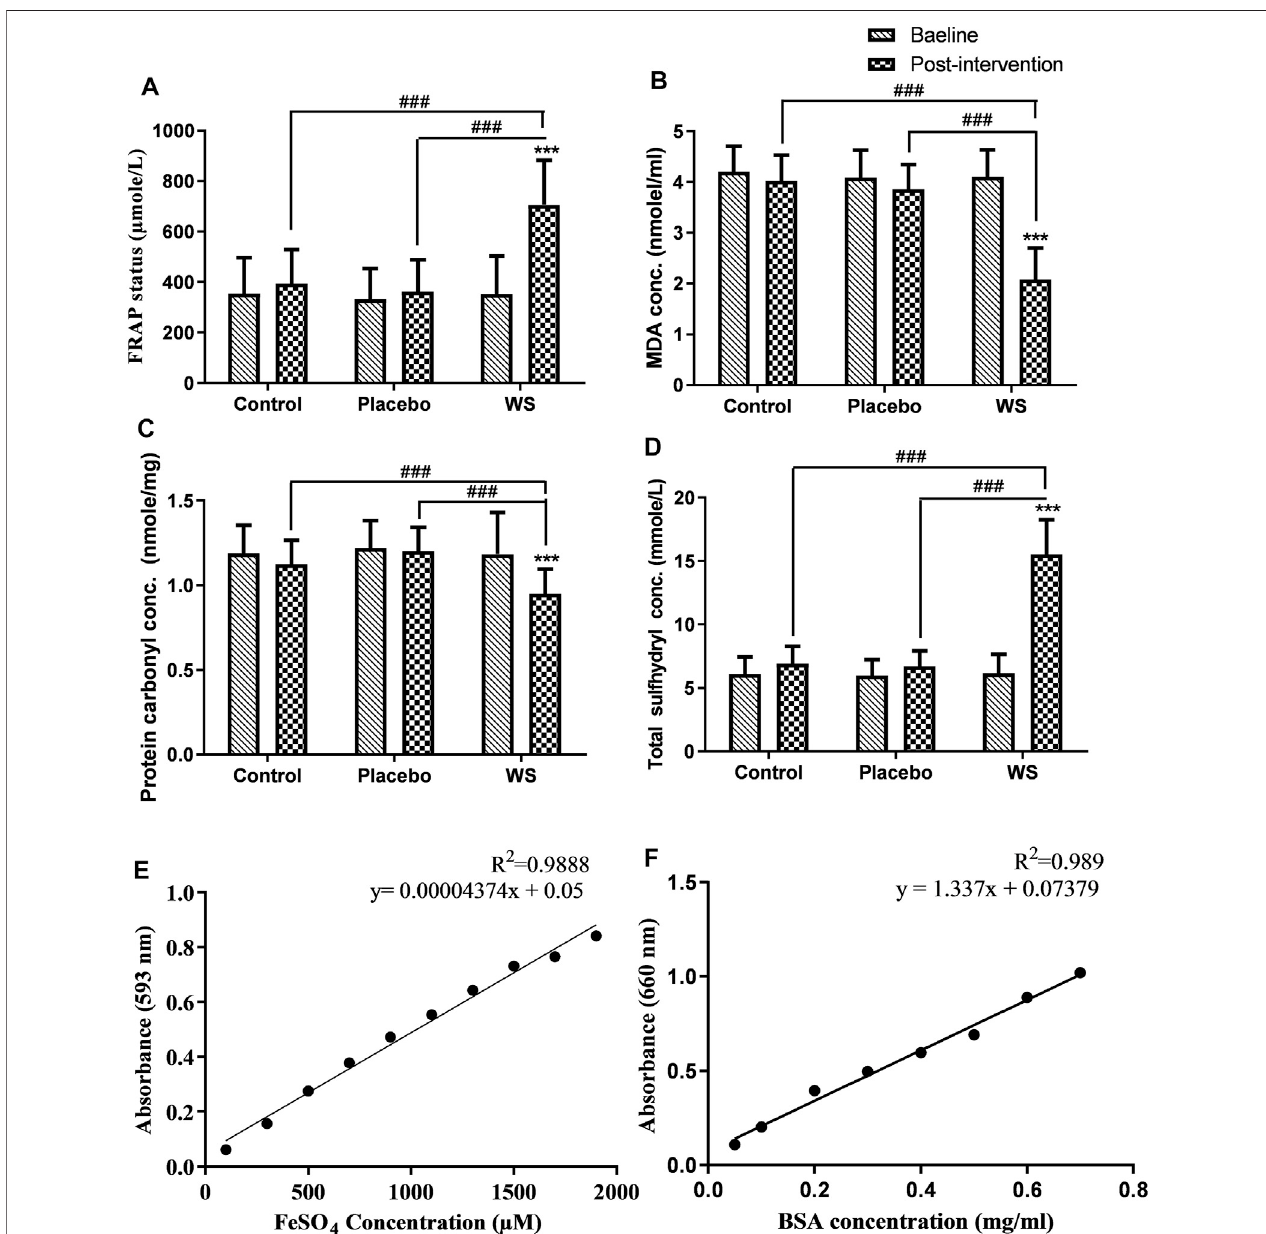
FIGURE5 | Effect ofinterventionson systemicOSof COPD patients: Mean (A) total antioxidant status (FRAP status), (B) MDA concentration, (C) protein carbonyl concentration, (D) total sulfhydryl concentration in plasma at the baseline and at the end of the study, (E) Standard curve of ferrous sulfate concentration, (F) Standard curve of BSA protein concentration. *** p ≤ 0.001 compared with baseline. ### p ≤ 0.001.